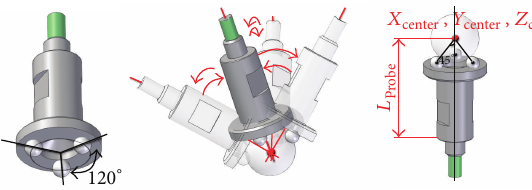
Figure 4: Probe used in the data acquisition